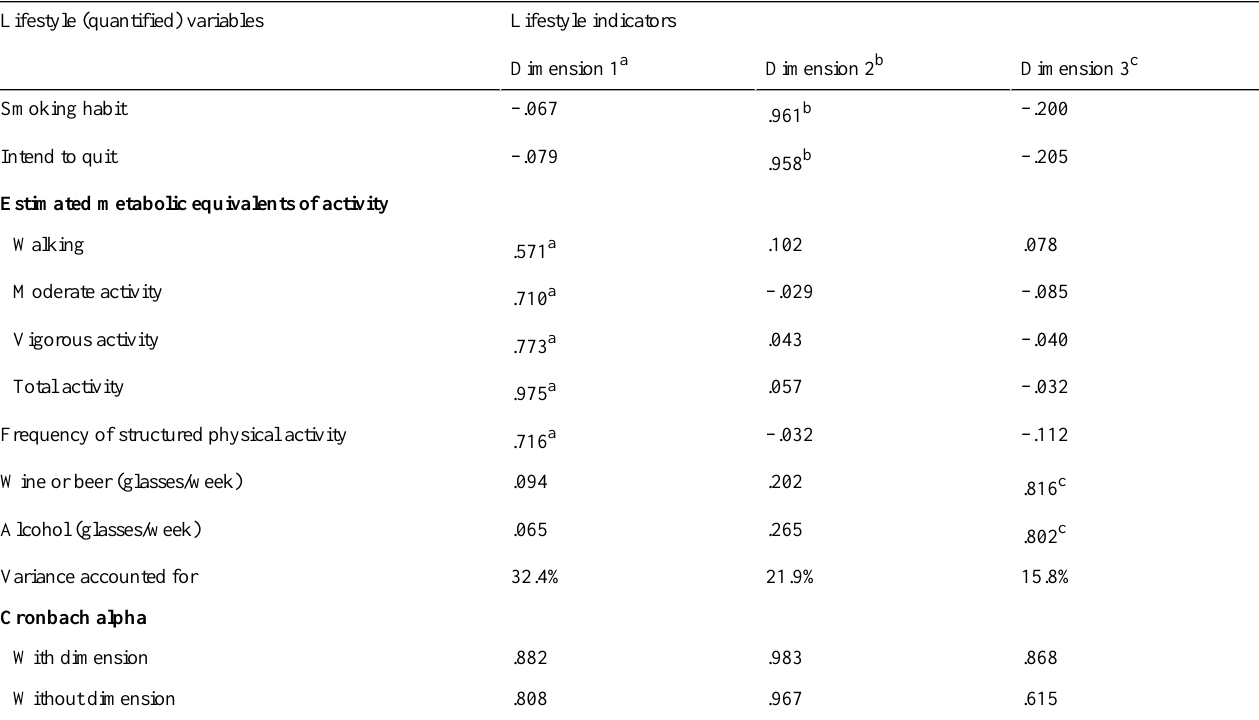
Table 3. Component loadings for lifestyle indicators